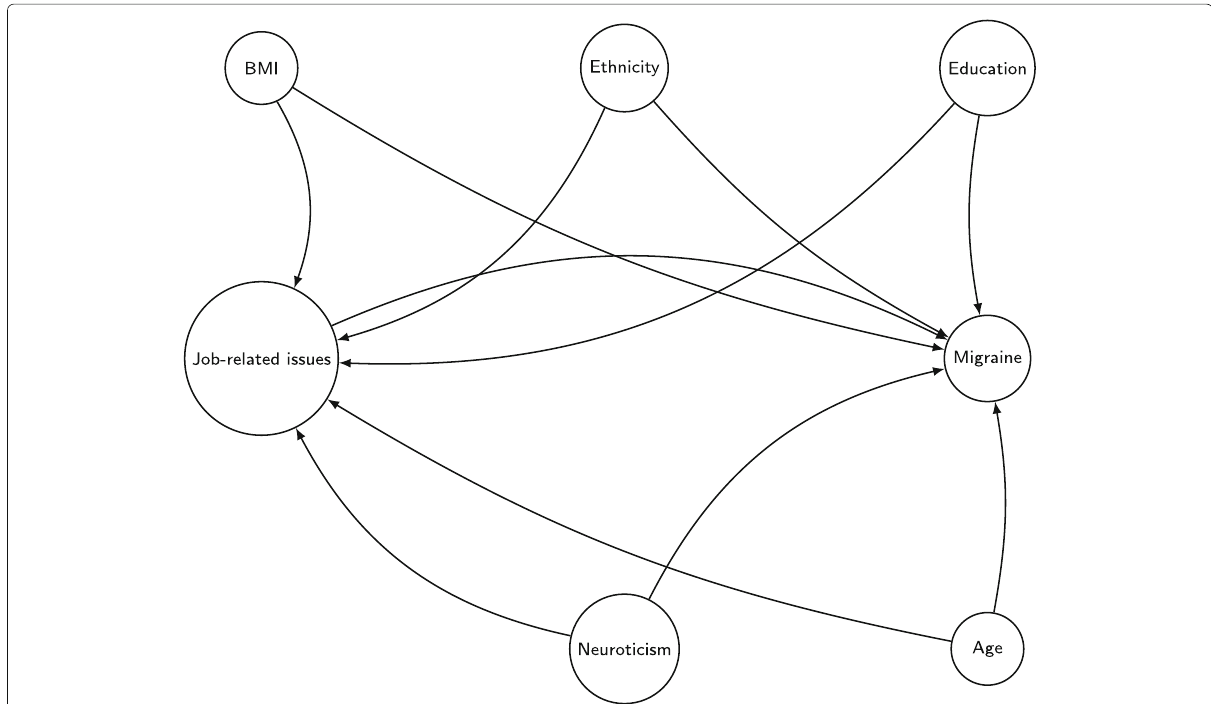
Fig. 1 Causal Direct Acyclic Graph illustrating the confounders considered in our